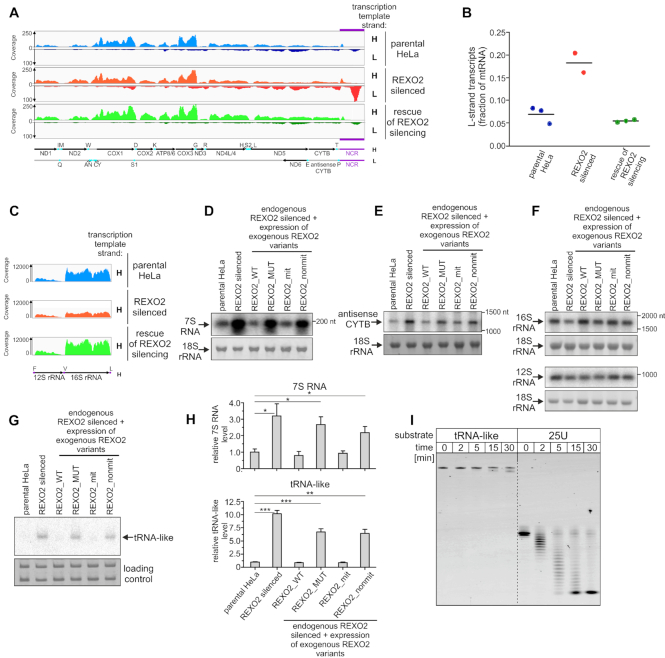
Depletion of REXO2 results in the accumulation of antisense L-strand-templated transcripts. (A, C) Tracks of RNA-seq reads mapped to the mitochondrial genome. RNA isolated from parental HeLa cells, REXO2-silenced cells, and cells that expressed ectopic REXO2_WT that replaced miRNA-silenced endogenous REXO2 (rescue of REXO2 silencing) was analyzed. The mitochondrial rRNA region is shown separately in C because of different coverage. The experiment was performed in triplicate. A map of mitochondrial transcripts is shown. The NCR region is highlighted in purple. (B) Graph of the contribution of L-strand-templated transcripts to the mitochondrial transcriptome. Individual values are shown. Horizontal lines represent mean values. (D–F) Confirmation of RNA-seq results by northern blot hybridization to detect 7S RNA, antisense CYTB, and mtDNA-encoded rRNAs, respectively. Nuclear-encoded 18S rRNA (methylene blue staining) was the loading control. (G) Northern blot analysis of tRNA-like. Nuclear-encoded 5.8S and 5S rRNAs (methylene blue staining) were the loading controls. (H) Quantification of northern blot analysis of tRNA-like and 7S RNA levels (mean ± SEM from three biological replicates) calculated relative to parental HeLa cells. A two-tailed unpaired t-test was applied (***P <0.001, **P 0.001 to 0.01, *P 0.01 to 0.05). (I) Results of in vitro degradation assay with the indicated substrates and recombinant REXO2.